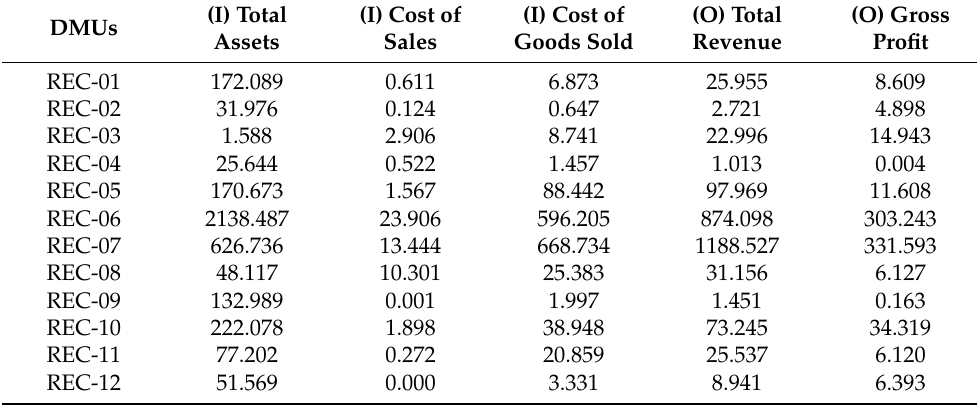
Table A8. The predictive data of the year 2022, (unit: million